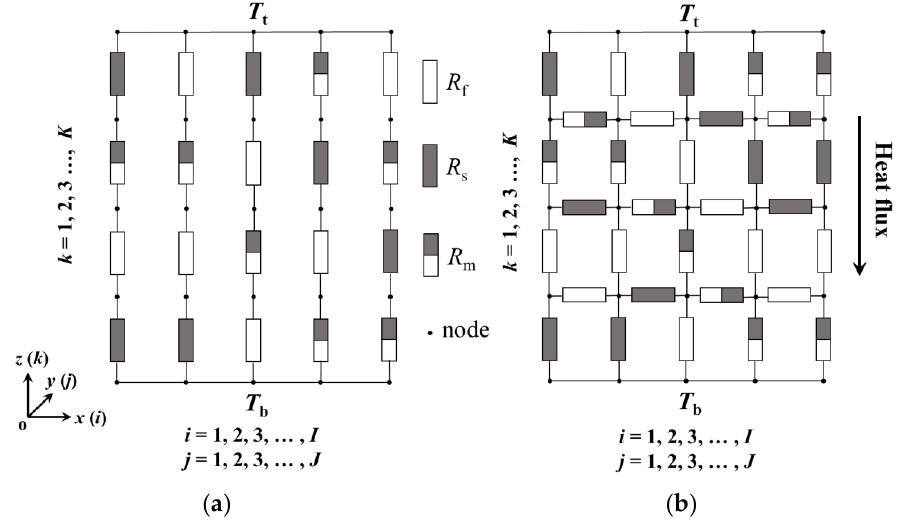
Figure 4. Thermal resistance networks on x - z cross section with a fixed y value: ( a ) the Ohm’s law model; and ( b ) the Kirchhoff’s law model.